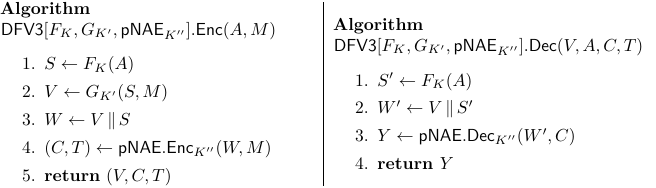
Figure 4: A nonce-stealing-based DFV ( DFV3 ). The functions F : K × A → S and is a pNAE with a nonce space W = { 0 , 1 } ν + n 0 , G : K 0 ×S ×M → V are PRFs, and pNAE K 00 where | V | = ν and | S | = n 0 . Tag T is τ